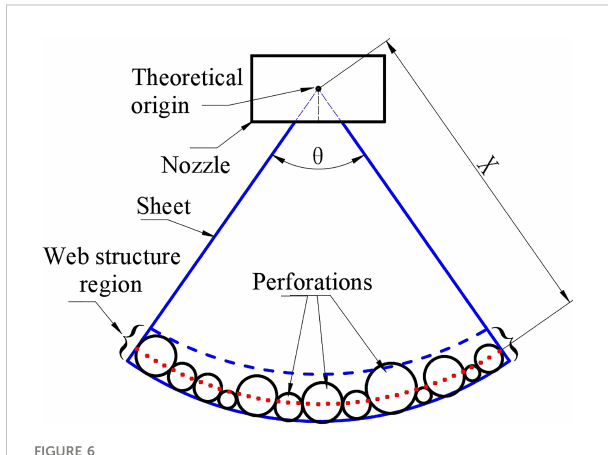
FIGURE 6 Theoretical schematic view of oil-based emulsion spray.